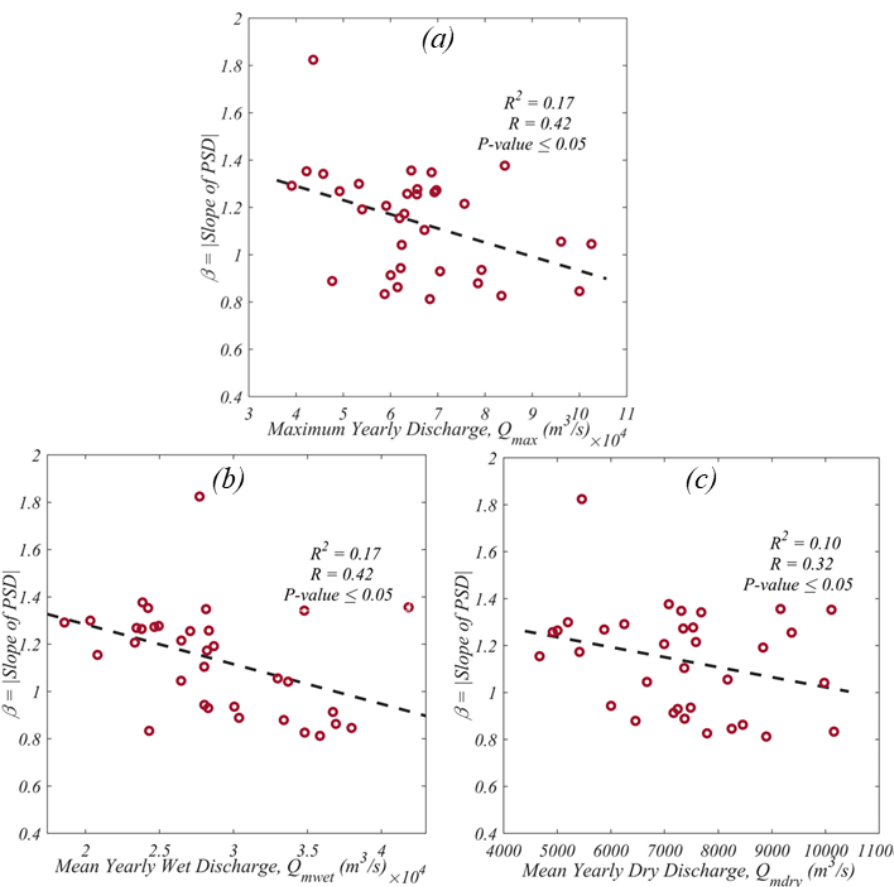
Figure 10. Correlation between β and ( a ) Yearly maximum discharge ( Q max ), ( b ) Mean yearly wet discharge ( Q mwet ) and ( c ) Mean yearly dry discharge ( Q mdry